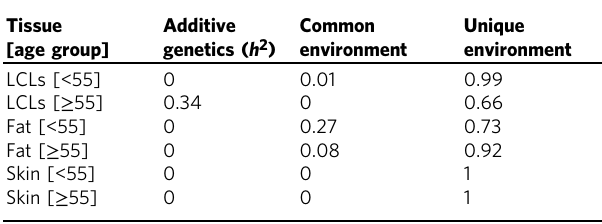
Table 4 XCI skew is heritable in blood-derived tissues of older females.